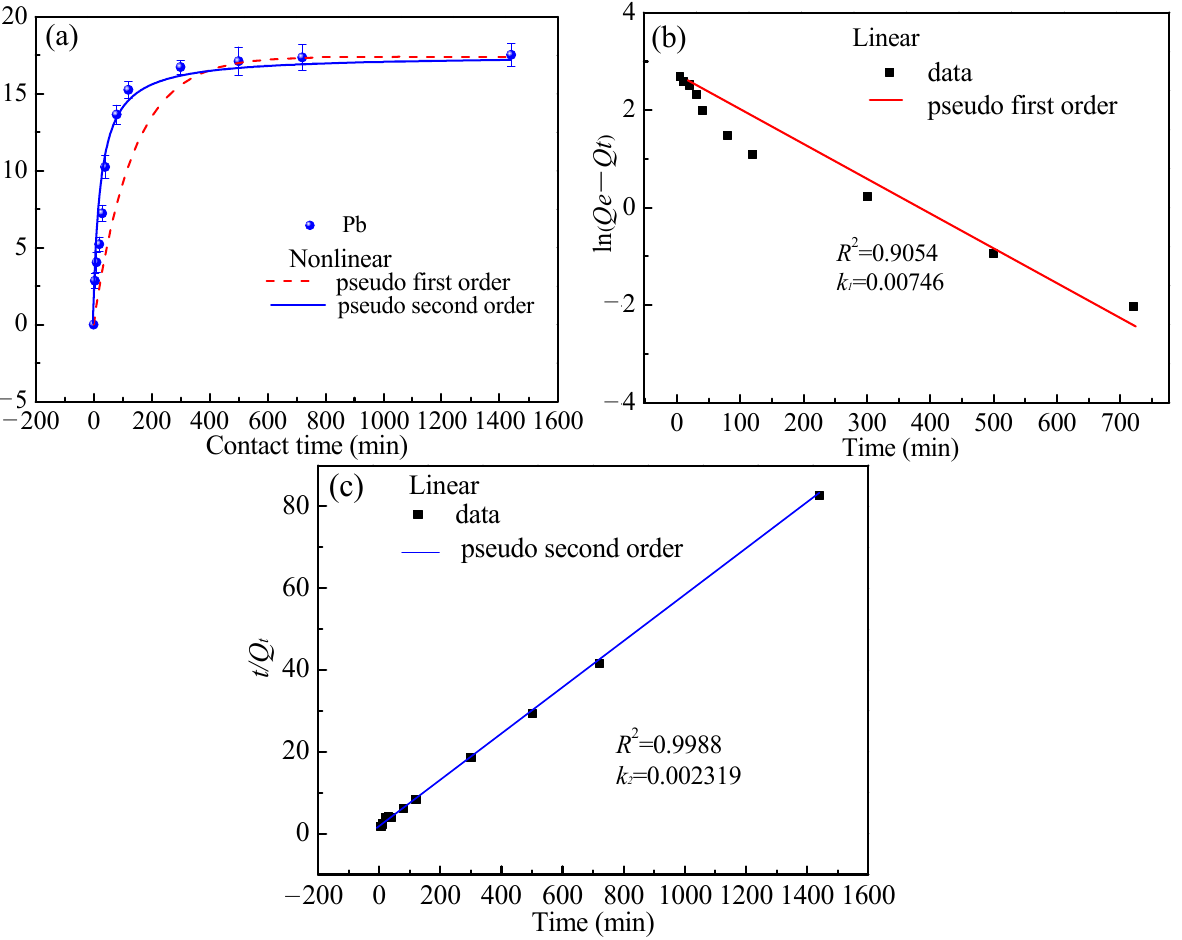
Figure 7. The adsorption kinetics. ( a ) effect of time on adsorption; ( b ) the fitting of pseudo first order; ( c ) the fitting of pseudo second order.